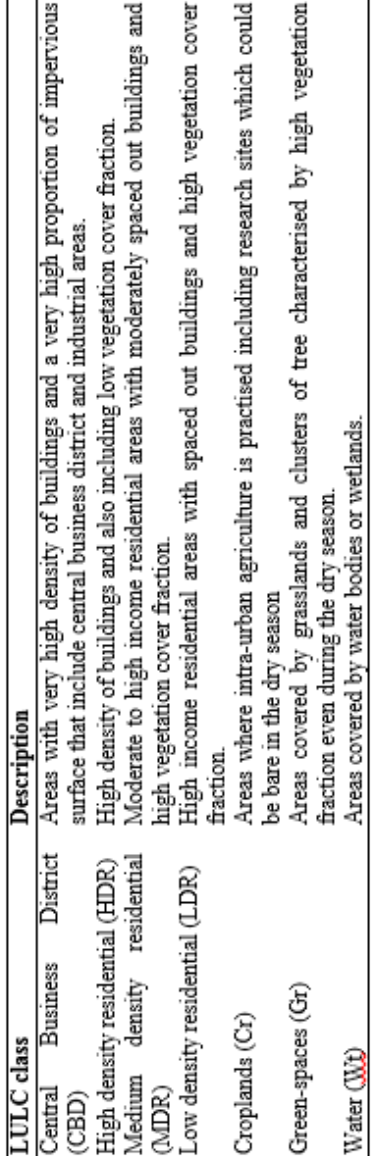
Table 1: Description of general land use and land cover